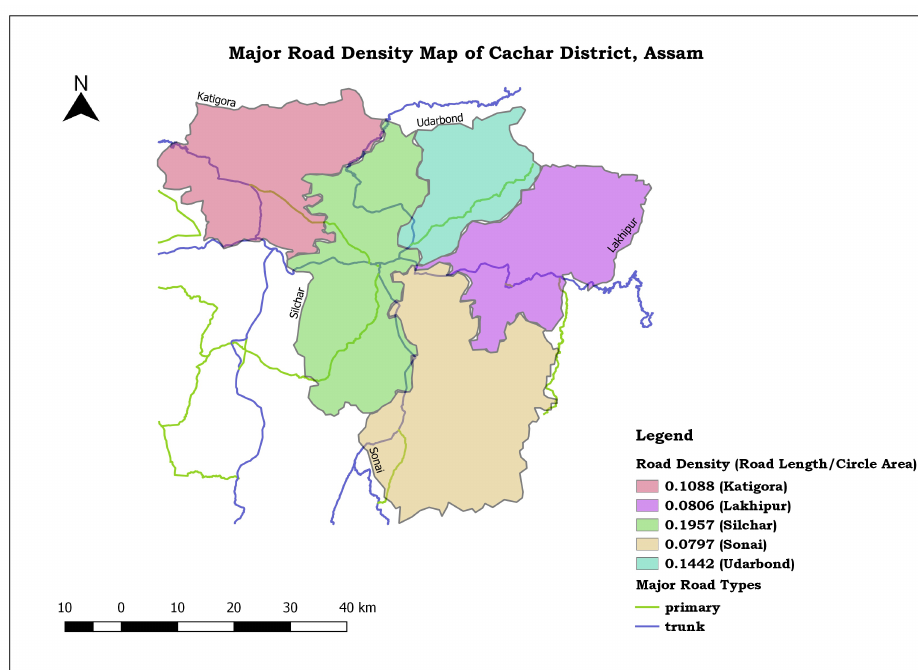
Figure 5. Major road density